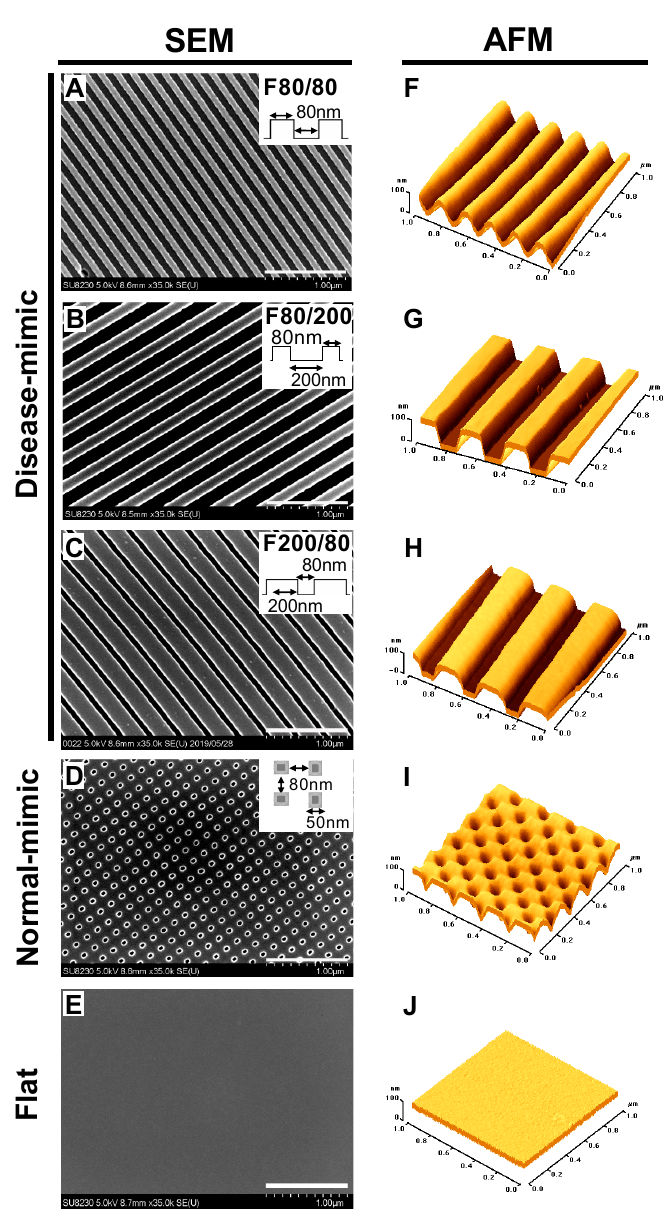
Figure 1. Images of fabricated titanium dioxide (TiO 2 ) nanopatterns. Scanning electron microscopy (SEM) was utilized to confirm the morphologies of three disease-mimic nanopatterns ( A – C ), a normal-mimic nanopattern, ( D ) and a flat control ( E ). Illustrations show the approximate dimensions of ridge / groove pattern arrays. The depth of gratings was 80 nm. Scale bar = 1 µ m. Atomic force microscopy (AFM) graphs show topographies of each TiO 2 nanopattern ( F – J ).